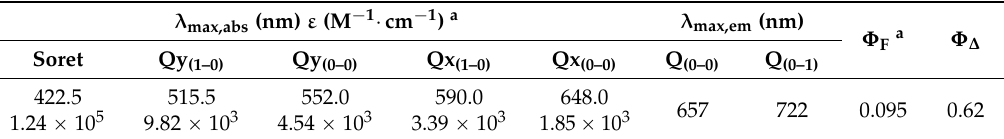
Figure 2. Absorption ( ‒ ) and fluorescence emission (···) spectra of 2-TQP (red) and TPP (black) recorded at room temperature in tetrahydrofuran (THF) and deaerated toluene solutions, respectively. Absorbance was monitored from 350 to 750 nm and fluorescence emission upon excitation at 552 nm was monitored from 560 to 800 nm.